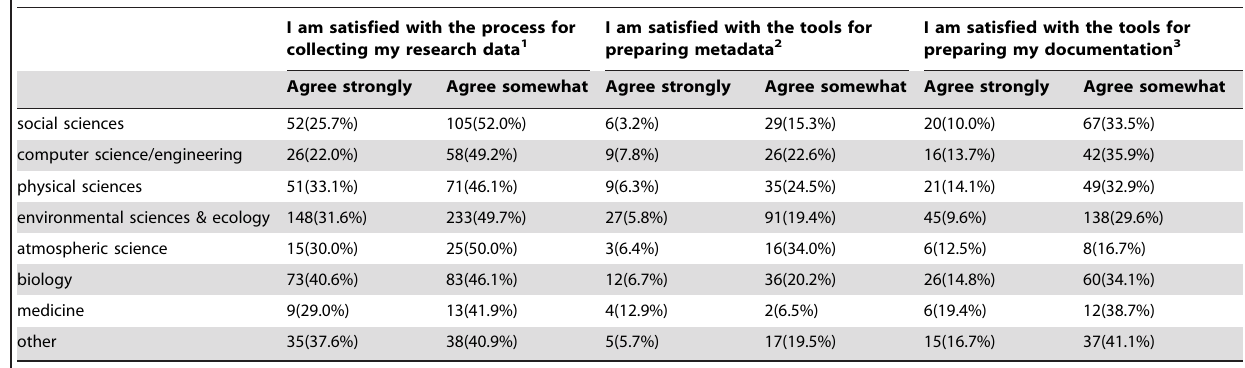
Table 17. Satisfaction for data management by subject discipline.